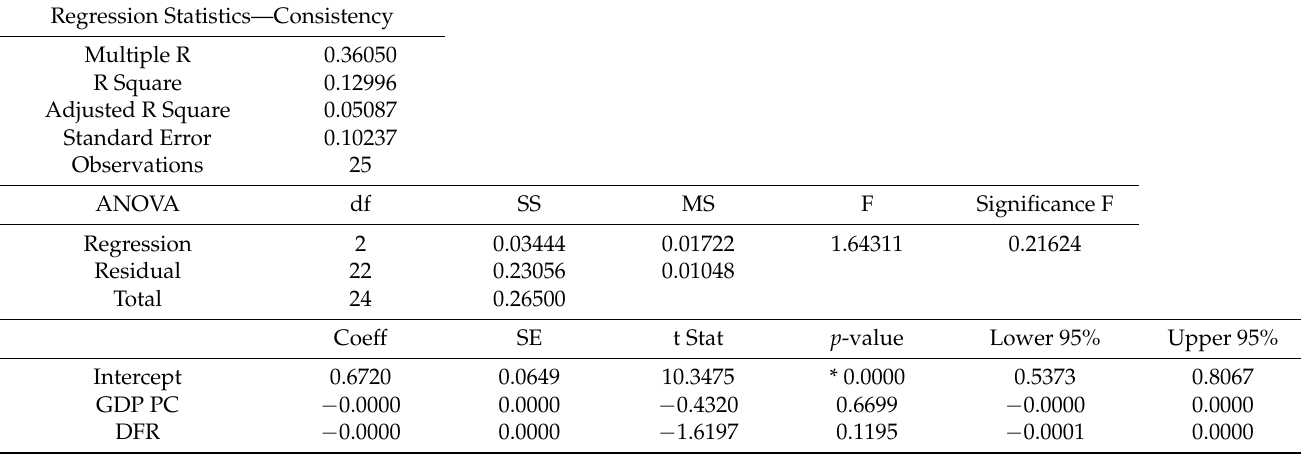
Table 5. Multiple linear regression model analysis in respect of DRs consistency.